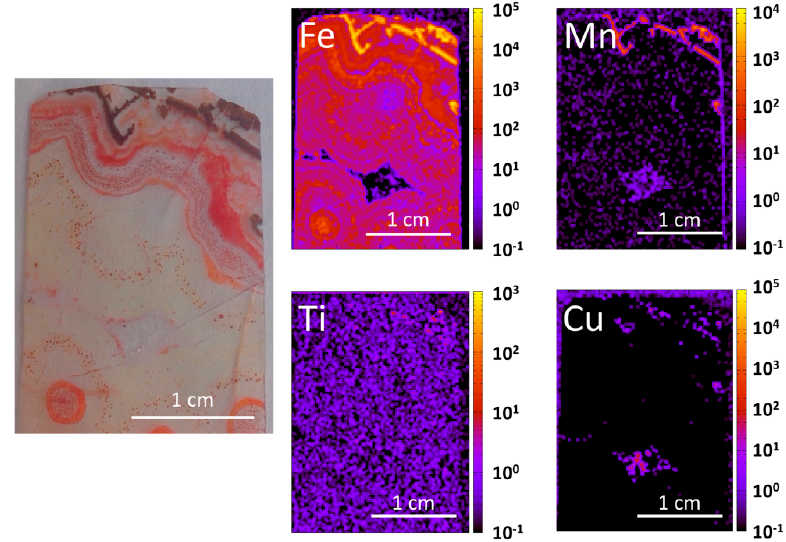
Figure 9. The photo of polycentric agate together with maps of characteristic K α X-ray intensities showing spatial distribution of Fe, Mn, Ti and Cu.